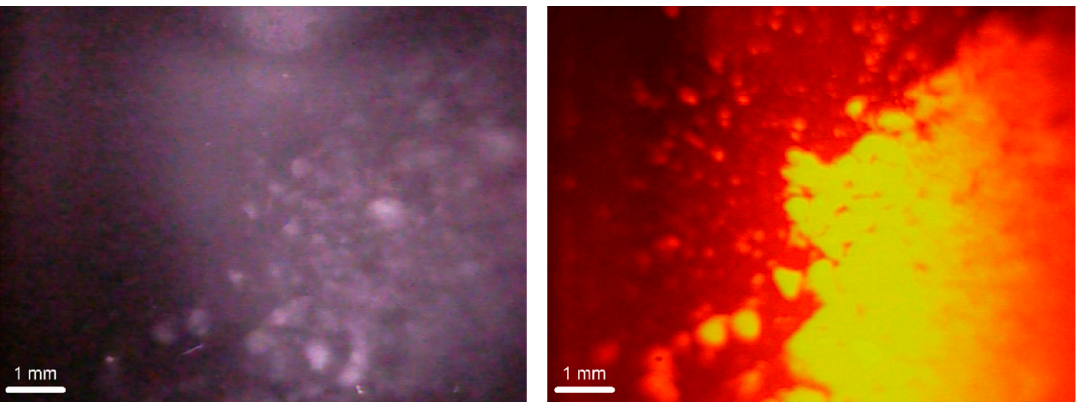
Figure 9. Sample CA-fluo0.2 dispersed in synthetic ground water under infrared light ( left ) and excited at 520 nm ( right ).